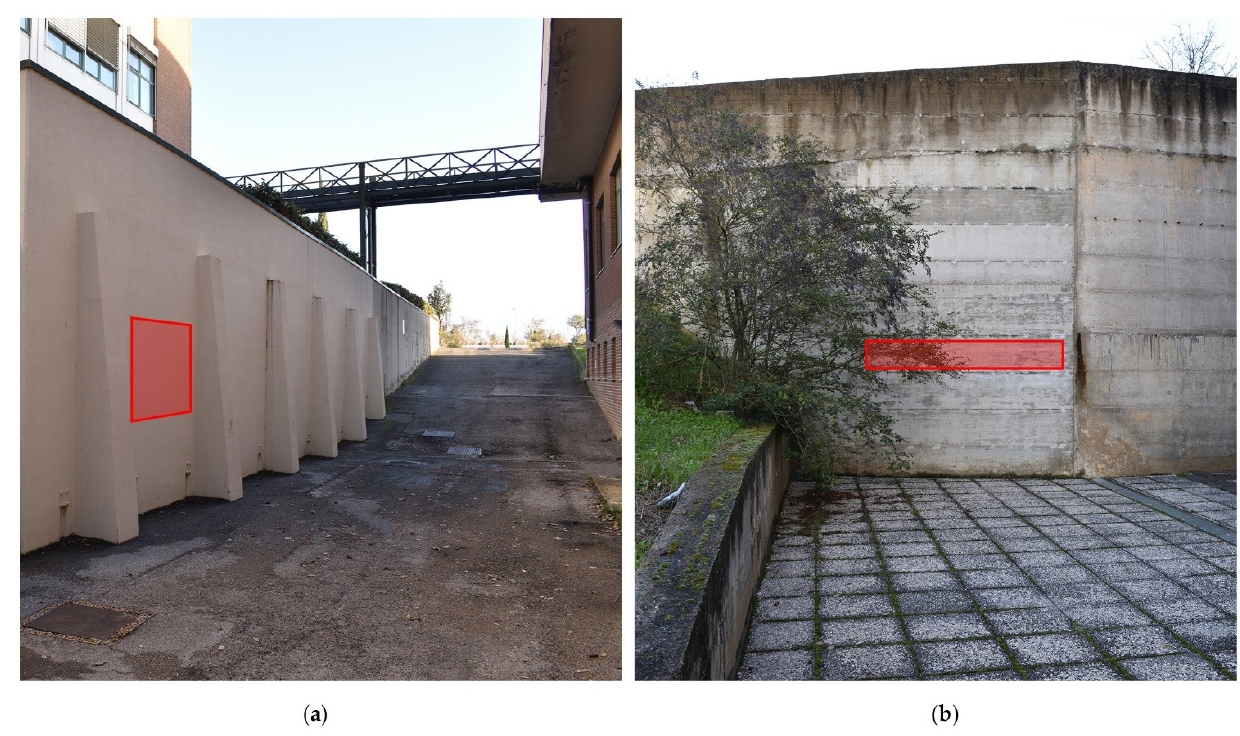
Figure 3. Tested concrete walls: ( a ) CLS1 wall with a homogeneous superficial layer of the material; ( b ) CLS2 wall with raw concrete material characterized by an evident state of degradation.